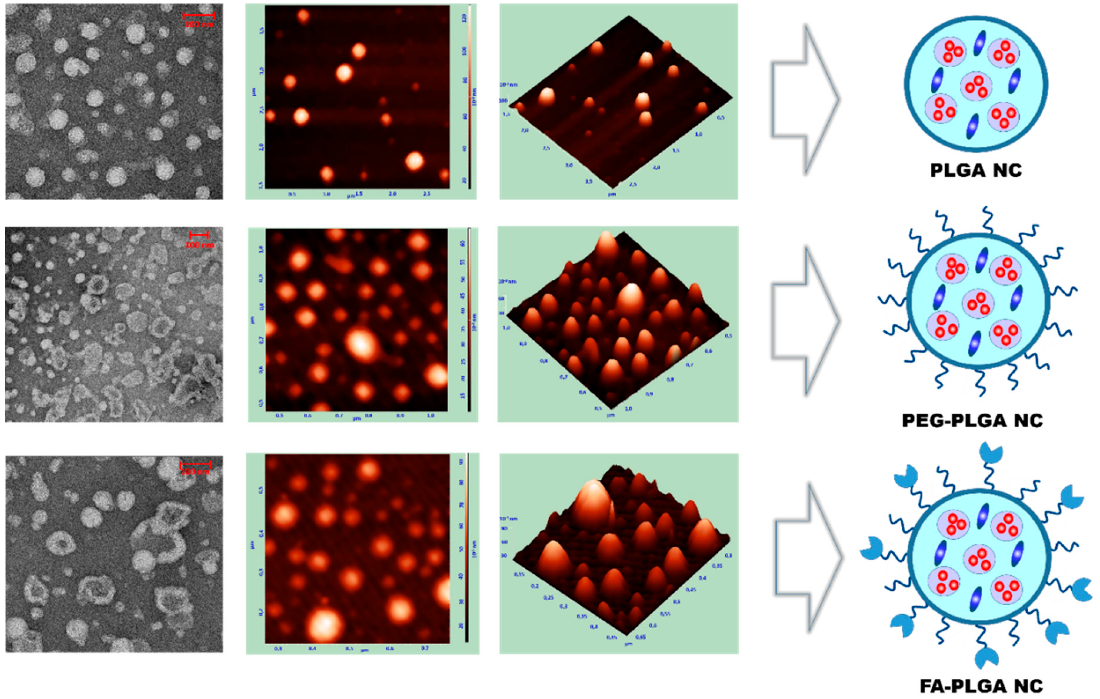
Figure 2. Imaging of VP and CisPt co-loaded PLGA (V1), PEG-PLGA (V2), and FA-PLGA (V3) NCs by means of transmission electron microscopy (TEM) and atomic force microscopy (AFM). See descriptions for the systems (V1–V3) in Table 1.